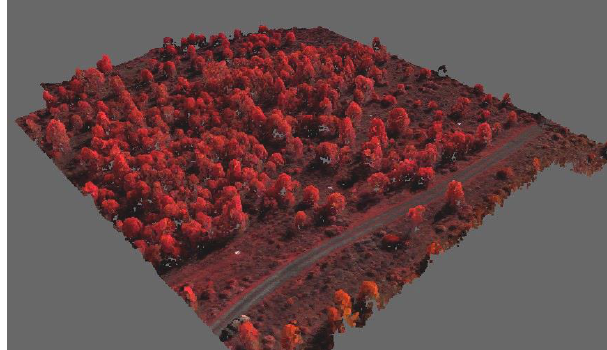
Figure 3. Hyperspectral point cloud of the study site